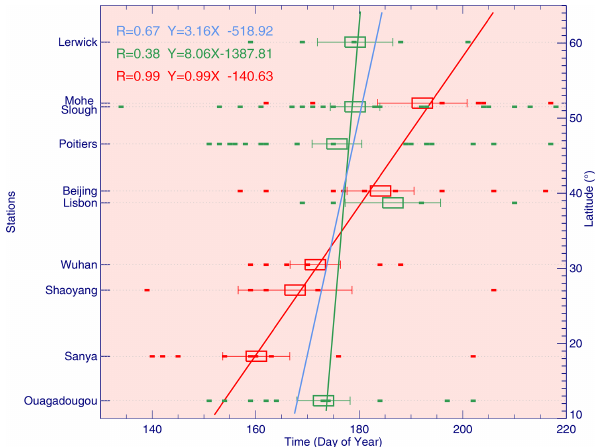
Figure 6. Latitudes of stations versus the mean day-of-year (DOY) time of the annual summer peaks for 10 stations from two merid- ional chains during 1975–2016. The ionosonde stations cover 10– 60 ◦ N. Green and red points are the annual summer peaks, and each point represents a DOY of a E s summer peak. The mean DOY time of summer peaks is shown as a box, with the error bar represent- ing the standard error in this mean for each station. The green, red, and blue lines show the linear fits between the peak time and lat- itude, using measurements from the Greenwich meridional chain, 120 ◦ E longitudinal chain, and the total of all 10 stations, respec- tively. The linear fit relationship and correlation coefficient are also given, from which an ion meridional velocity in a meridional chain could be quantitatively